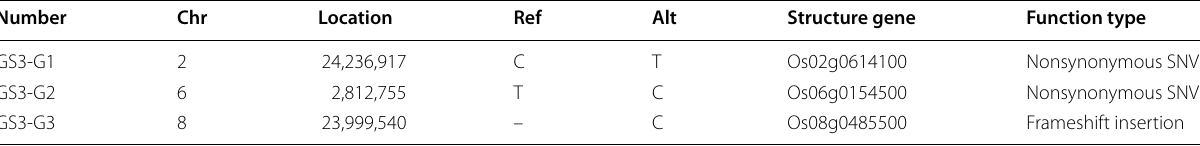
Table 4 Whole-genome mutation site